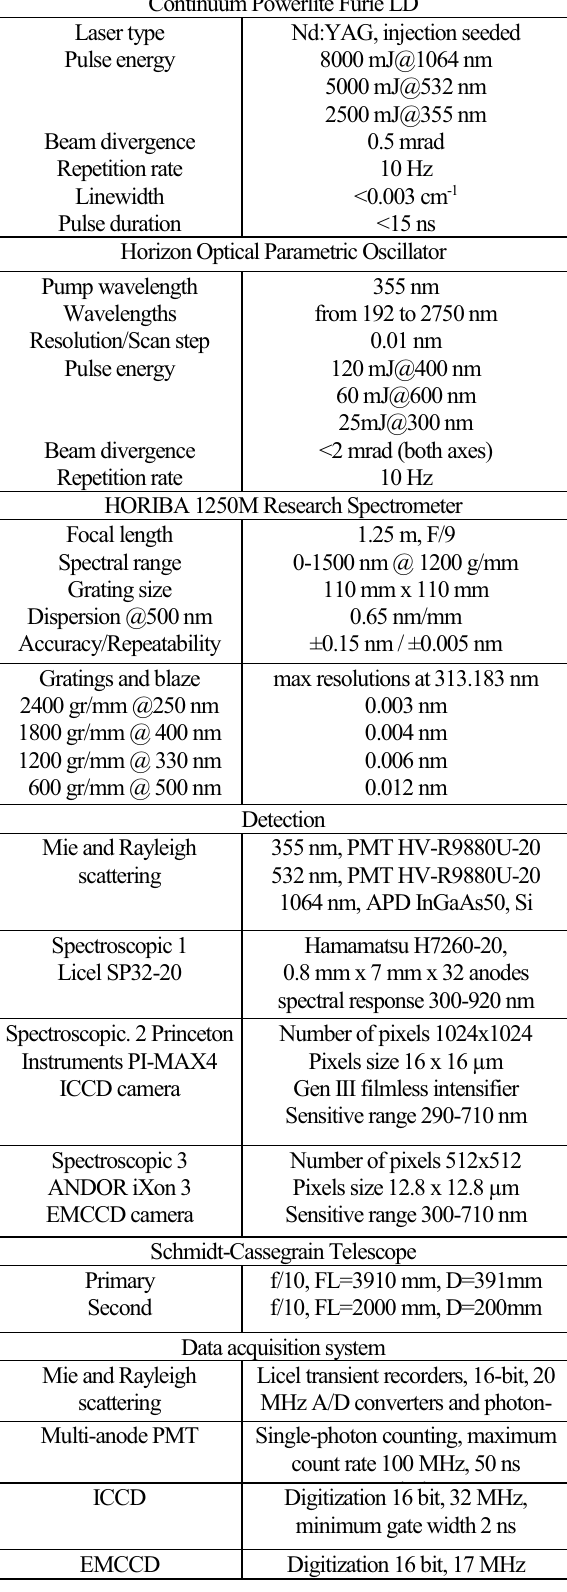
Table 1. Technical specification of the lidar systems Continuum Powerlite Furie